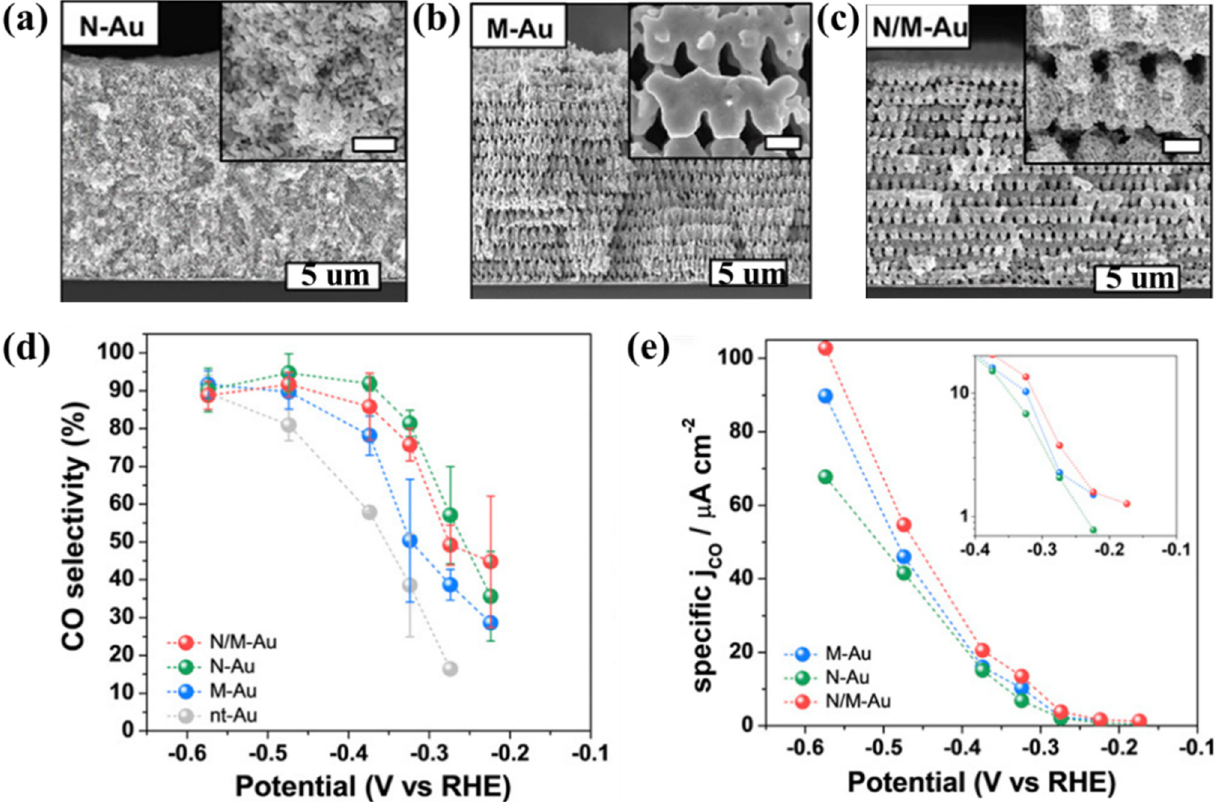
Figure 5. ( a – c ) Low- and high-magnification SEM images of N-Au, M-Au, N/M-Au. (Inset scale bars, 500 nm.) ( d ) CO selectivity of various gold nanostructures. ( e ) j co of each nanostructured electrode. Reproduced with permission from Ref. [83]. Copyright 2020, National Academy of Sciences.